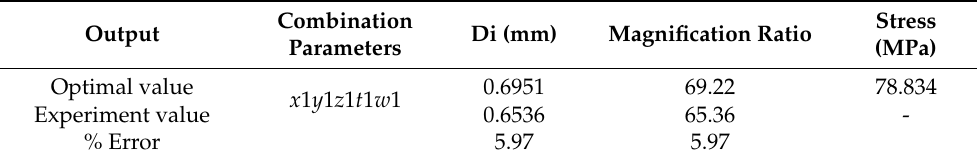
Figure 10. ( a ) The experimental set-up. ( b ) Larger view of the bridge-type compliant mechanism. The experimental results measured an output displacement of 0.6536 mm, and a displacement amplification ratio of 65.36. The optimal result and the experiment result were in good agreement, with a deviation of 5.97%, as depicted in Table 10. These values are better than those obtained in previous studies [3,7–10]. Table 10. Comparison of the optimal value with the experimental